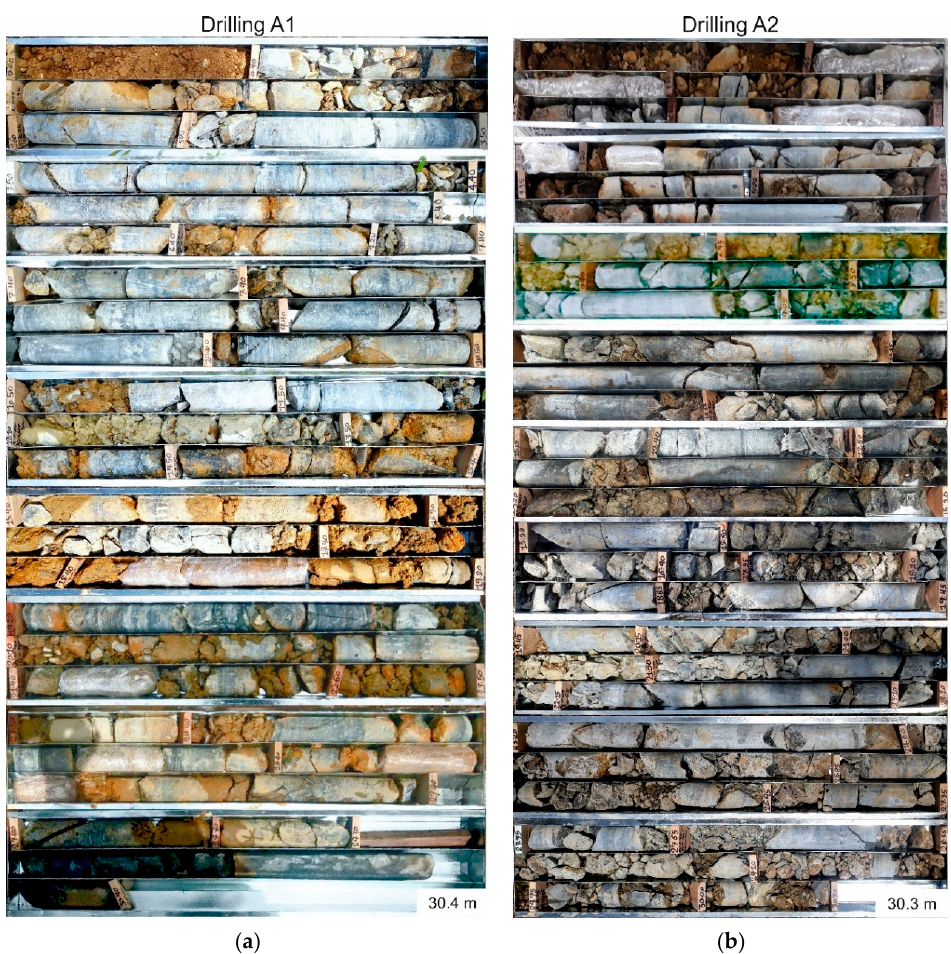
Figure 6. ( a ) Picture of the drilling core of drilling A1; ( b ) Picture of the drilling core of drilling A2. The cores have a length of 1 m each and run from top left to bottom right.